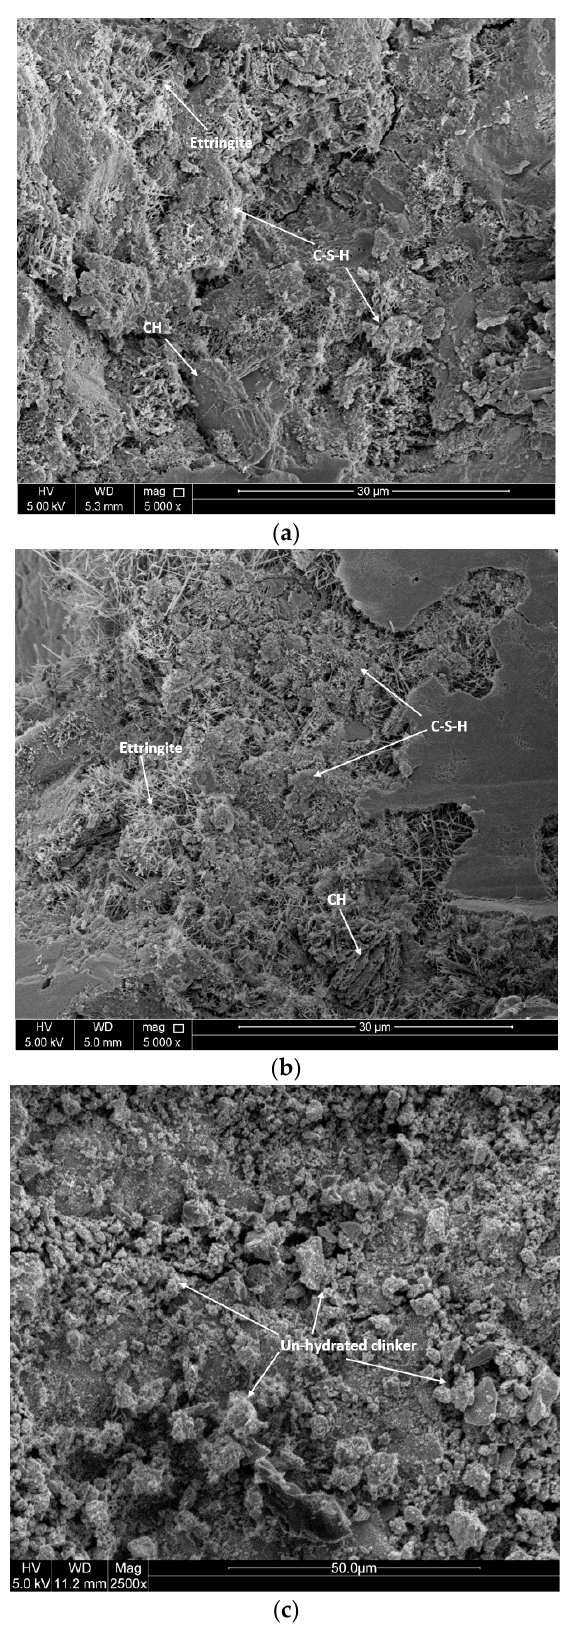
Figure 6. SEM images for selected mortar specimens with ( a ) 0% carbon dust, ( b ) 5% carbon dust, ( c ) 40% carbon dust.